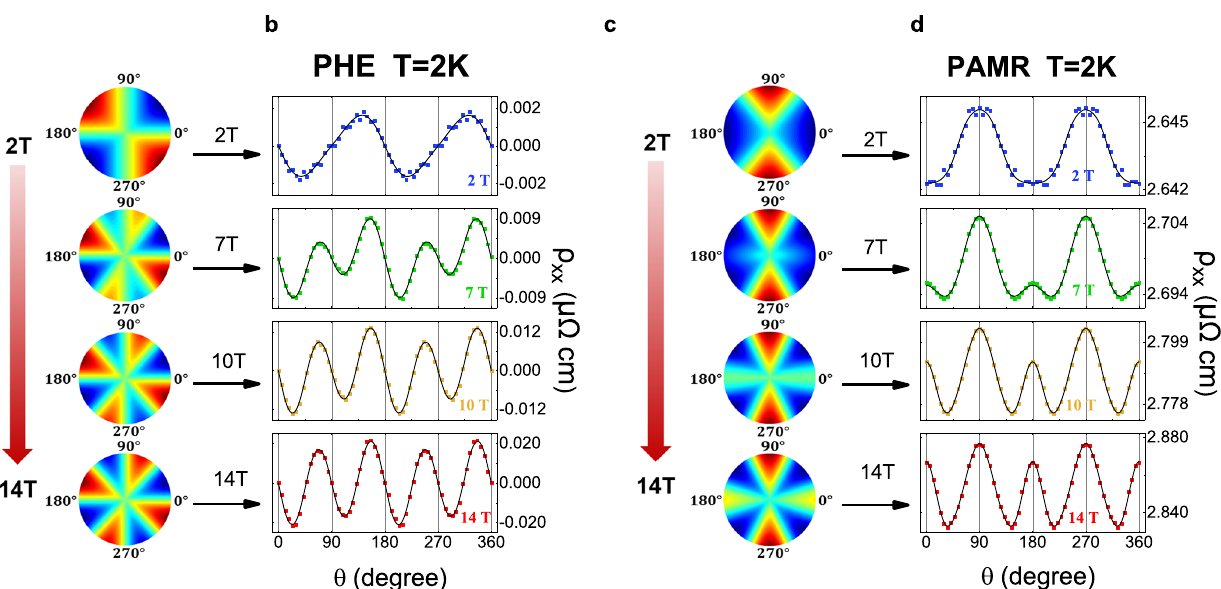
Fig. 2 PHE and PAMR for KV 3 Sb 5 at 2 K. a , c The 2D color plots for PHE and PAMR at 2 K with μ 0 H = 2, 7, 10, and 14 T respectively in the polar coordinates where r represents the applied fi eld, θ is the rotating angle, the red region represents higher resistivity, and the blue region represents lower resistivity. b , d The related data of ρ xy ( θ ) and ρ xx ( θ ) from ( a , c ). The experimental data are marked by open symbols and the fi tting curves by formulas 3 and 4 marked by solid